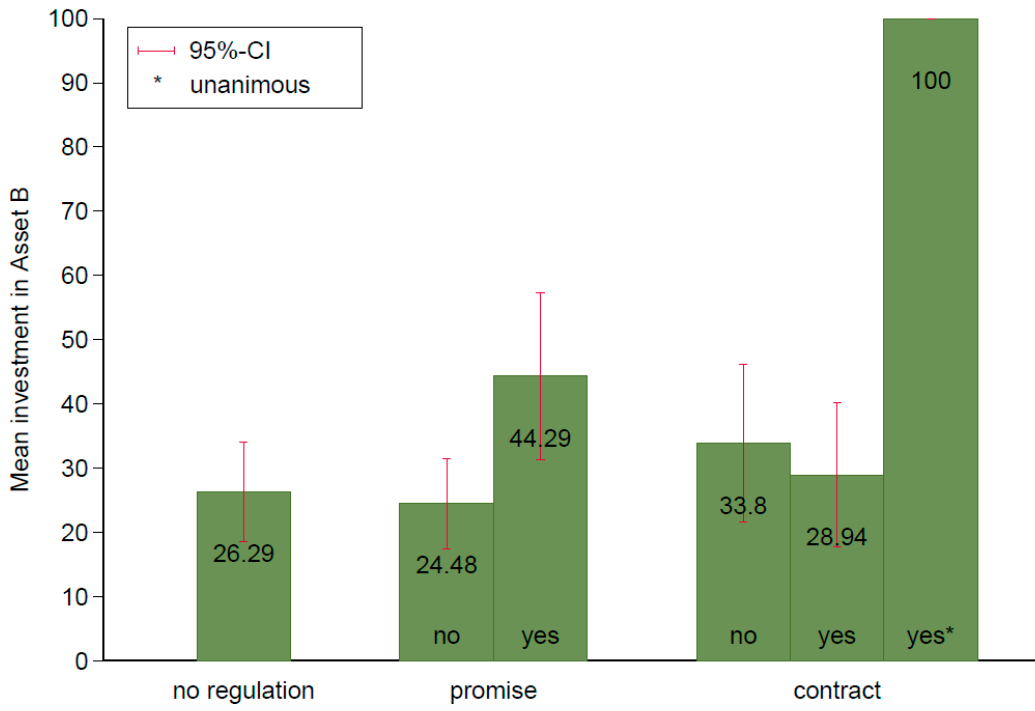
Figure 1. Mean investment in Asset B.